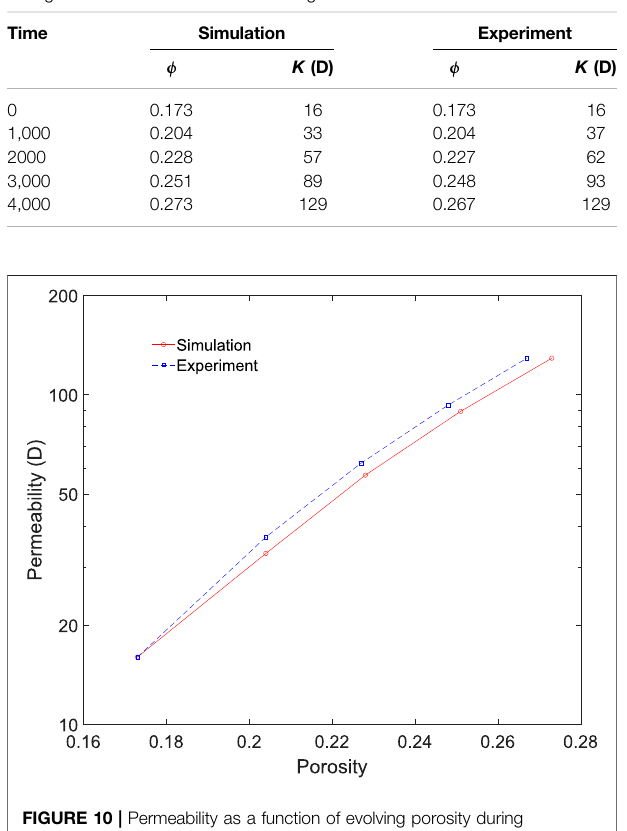
FIGURE 10 | Permeability as a function of evolving porosity during dissolution in a 3D micro-CT image of Ketton Carbonate.